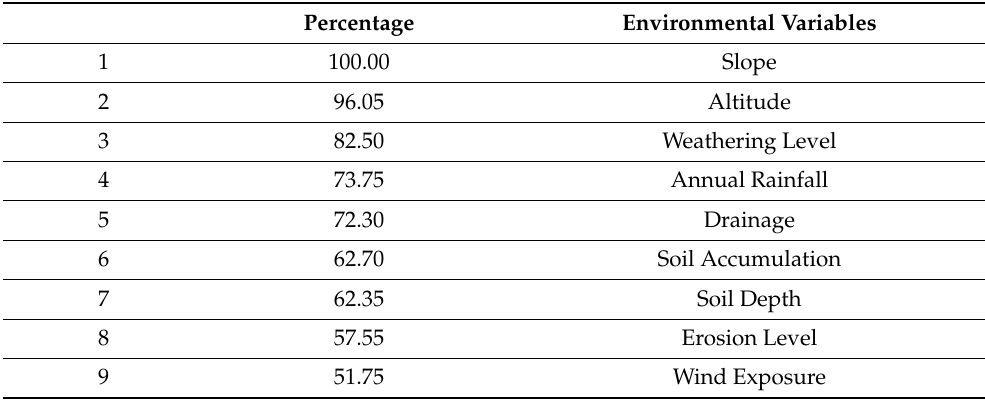
Table 4. Attribute usage of Decision Tree